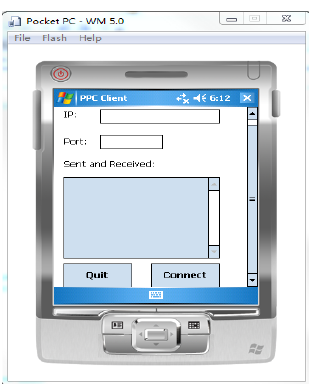
Figure 10. GUI on the PDA